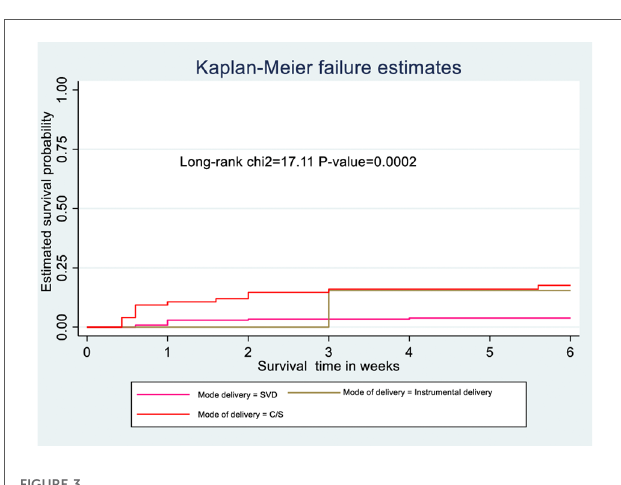
FIGURE 3 Kaplan-Meier curve showing the survival probability of developing puerperal sepsis among postnatal women based on the mode of delivery.